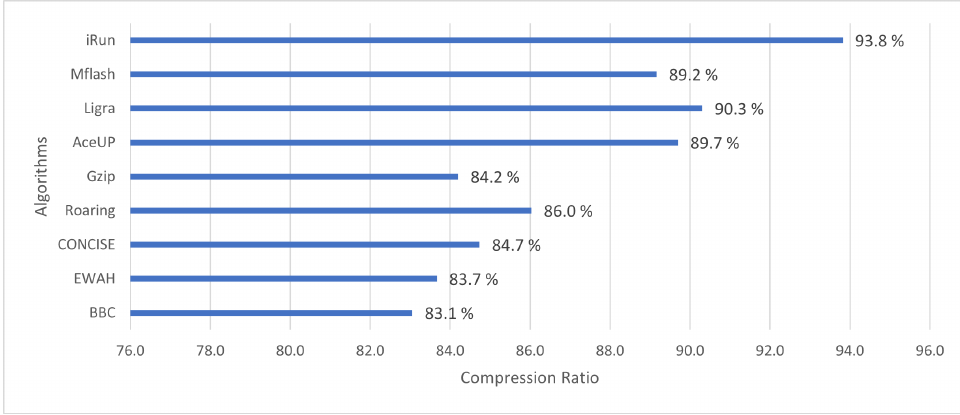
Figure 11. Compression